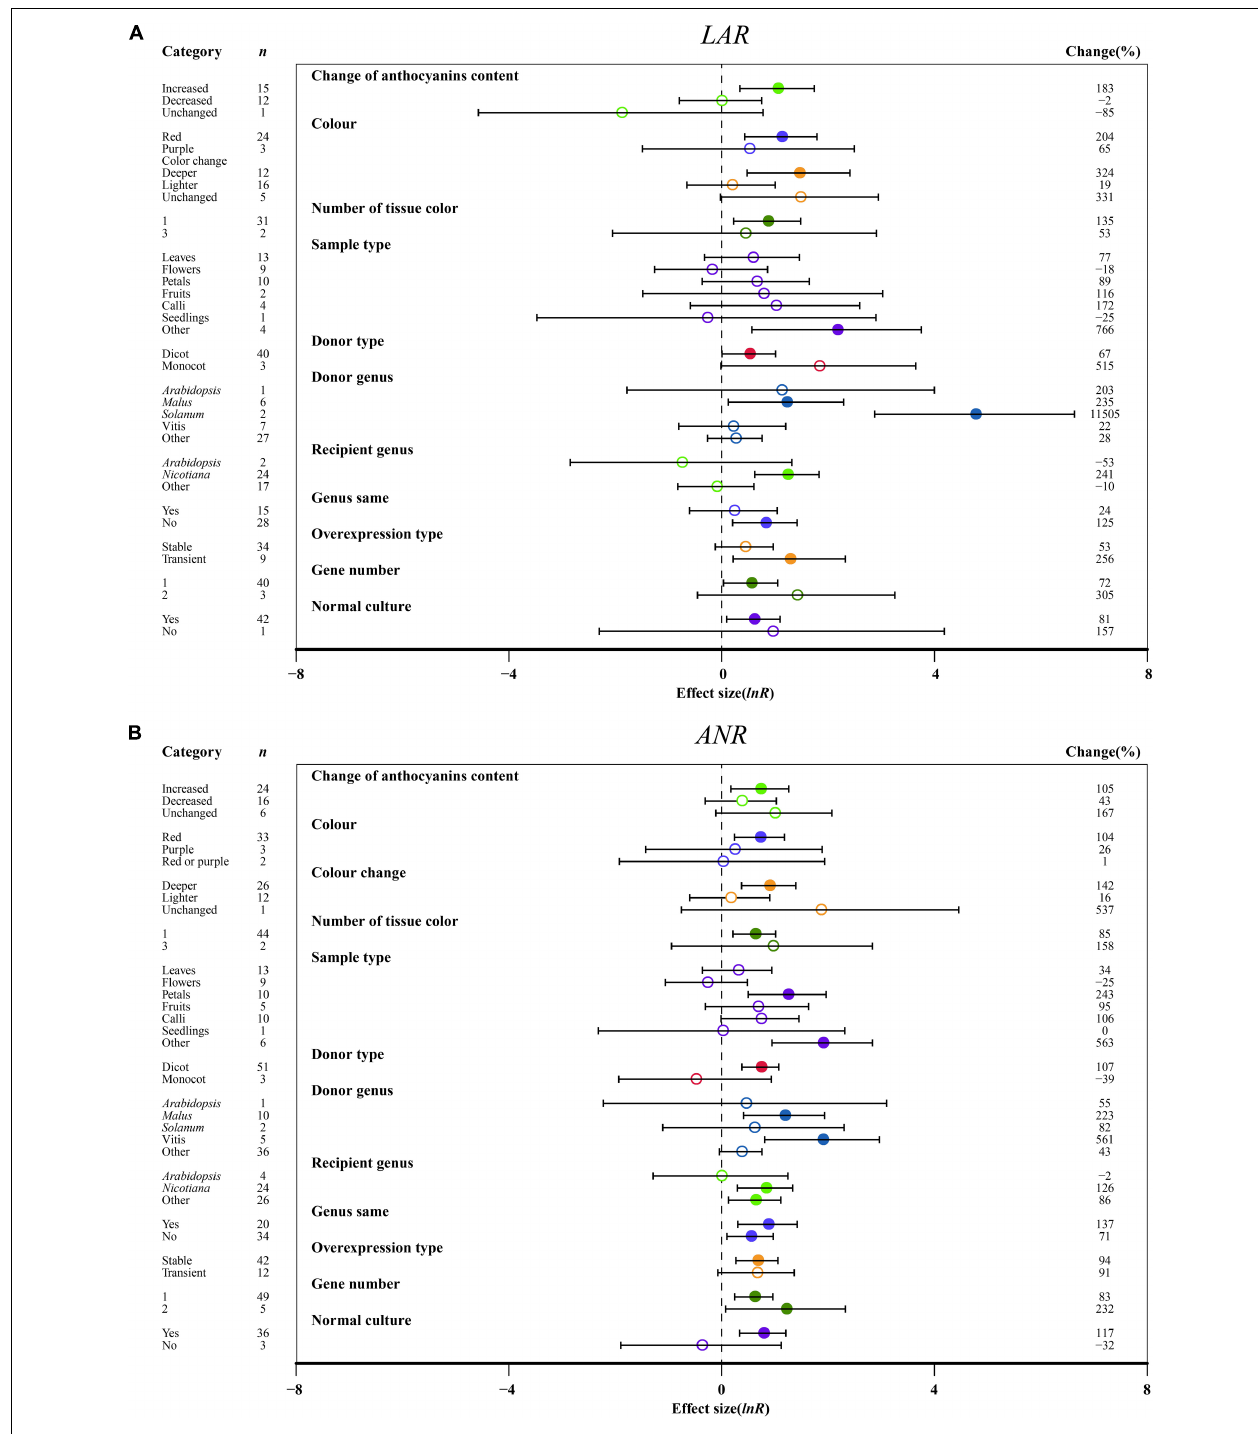
FIGURE 8 | Summary effects (ln R ) of the influence of MYB overexpression on the expression of LAR (A) and ANR (B) in plants. Ratios are unit-less. The ratios illustrate the strength of MYB overexpression on the summary effects of the expression of LAR and ANR compared with the controls. Circles and horizontal bars indicate the summary effects and the 95% CI of eleven (A) owing to insufficient studies, some moderators not analyzed) and twelve (B) owing to insufficient studies, “recipient type” not analyzed) moderator variables, respectively. n represents the number of studies. Subgroup list levels (subgroups or categories) of each moderator. The percent change (to the right of plots) refers to the raw percentage increase or decrease in the expression of LAR and ANR induced by overexpression of MYB . The moderator variables of the examined plants are colored and distinguished by different colors. Closed and open circles indicate the effects of significance and insignificance,